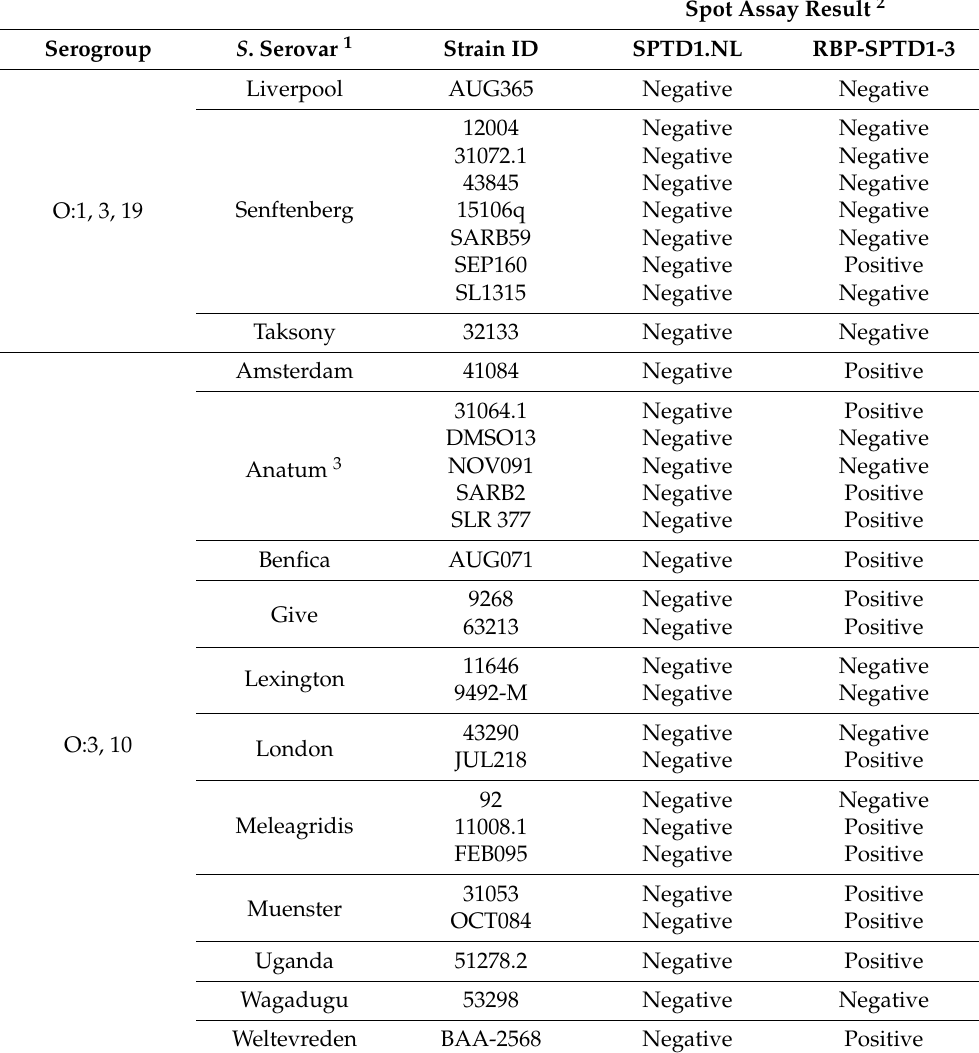
Table 3. Comparison of SPTD1.NL and RBP-SPTD1-3 Activity on O:3-Containing Salmonella